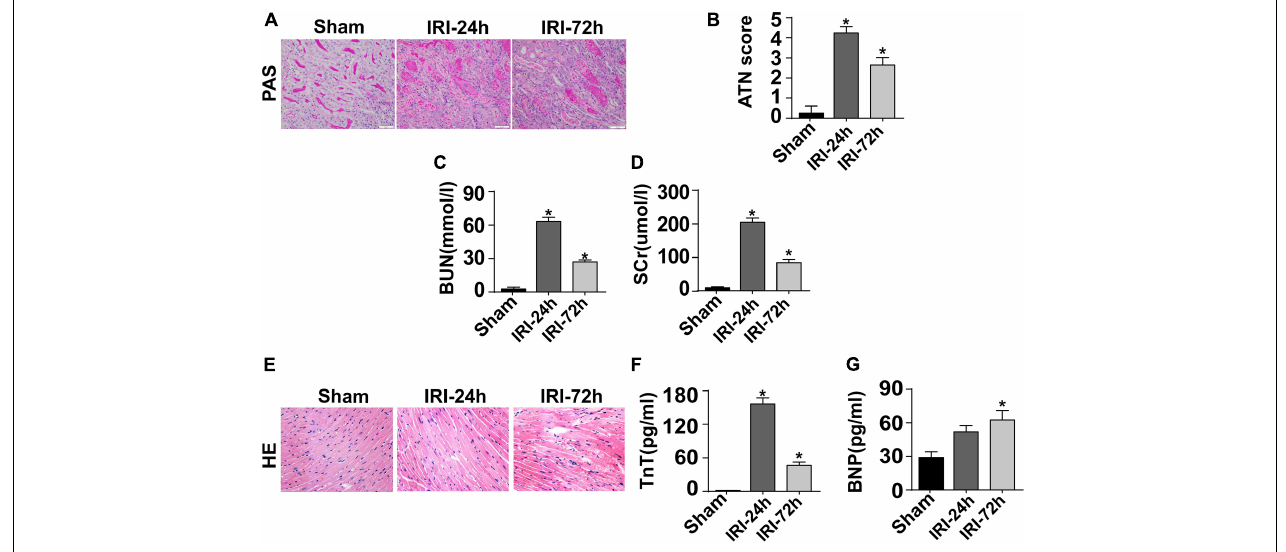
FIGURE 1 | CRS-3 is featured by decreased cardiac dysfunction. (A,B) Periodic acid–Schiff staining for damaged renal structure. Semi-quantitative analysis of tubular injury (tubular atrophy or dilatation, loss of brush border, vacuolization, epithelial cell shedding, and denuded tubular basement membrane) was scored as follows: 0, normal; 1, < 10%; 2, 10–25%; 3, 25–50%; 4, 50–75%; and 5, 75–100% of the affected area from 20 random fields. (C,D) Levels of BUN and serum creatinine from mice after acute kidney injury (AKI). (E) H&E staining for heart tissue from mice treated with AKI or not. (F,G) Levels of TnT and serum BNP from mice after AKI. * p < 0.05 vs. sham group.